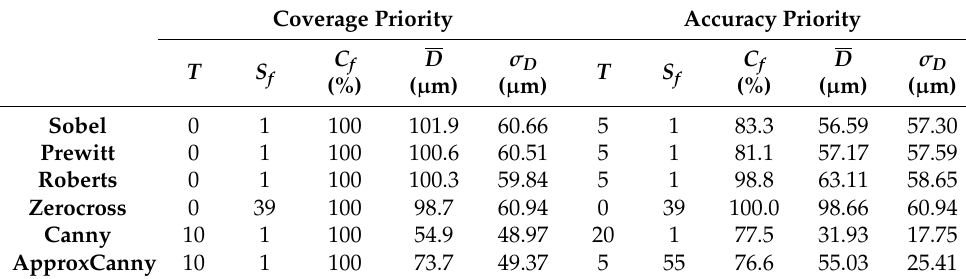
Table 7. Optimal combinations of test parameters for S